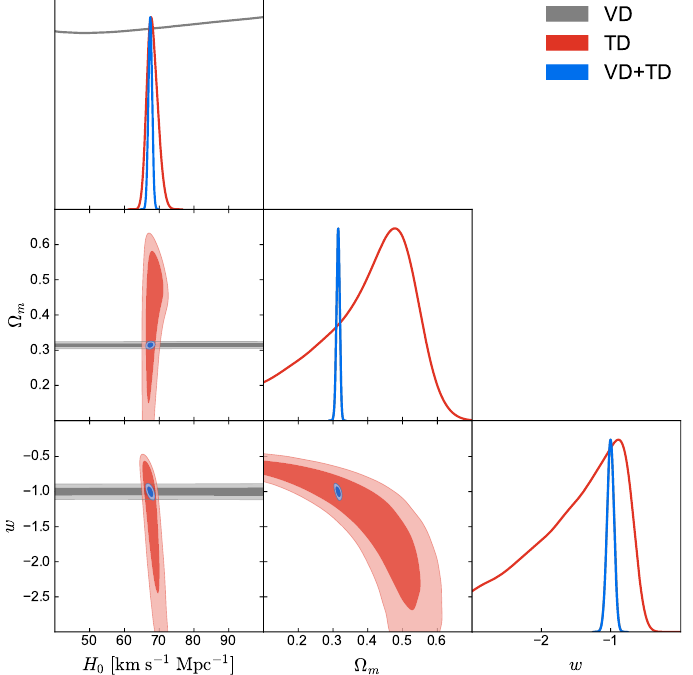
Figure 5. The constraints (68.3% and 95.4% confidence level) on the w CDM model from the simula- tions of VD, TD, and